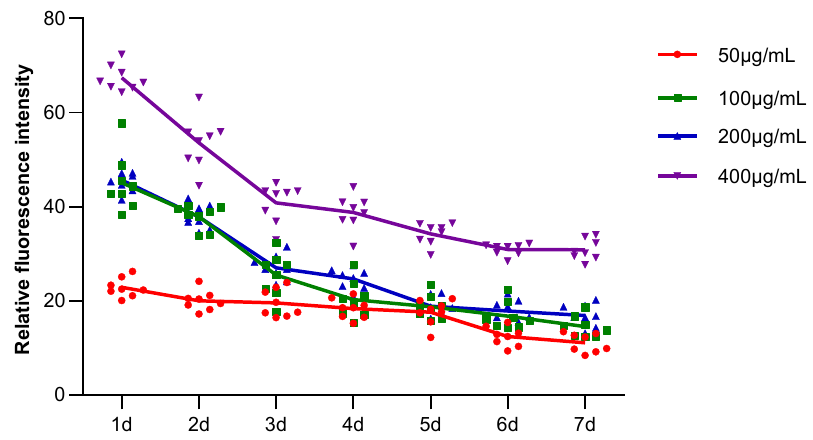
Figure 13. AGQDs-labeled HSFs, 7-day fluorescence attenuation statistics.